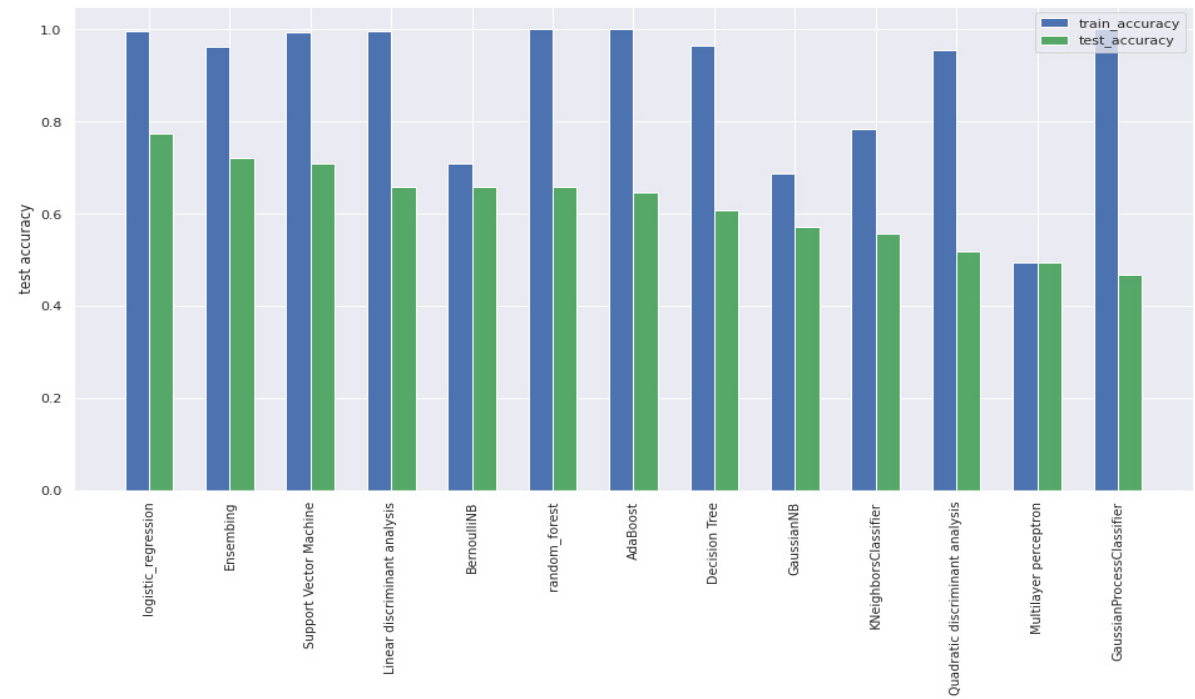
Figure A4. Pair plot of all the score of the analysis 1—Remobi vergence dataset.